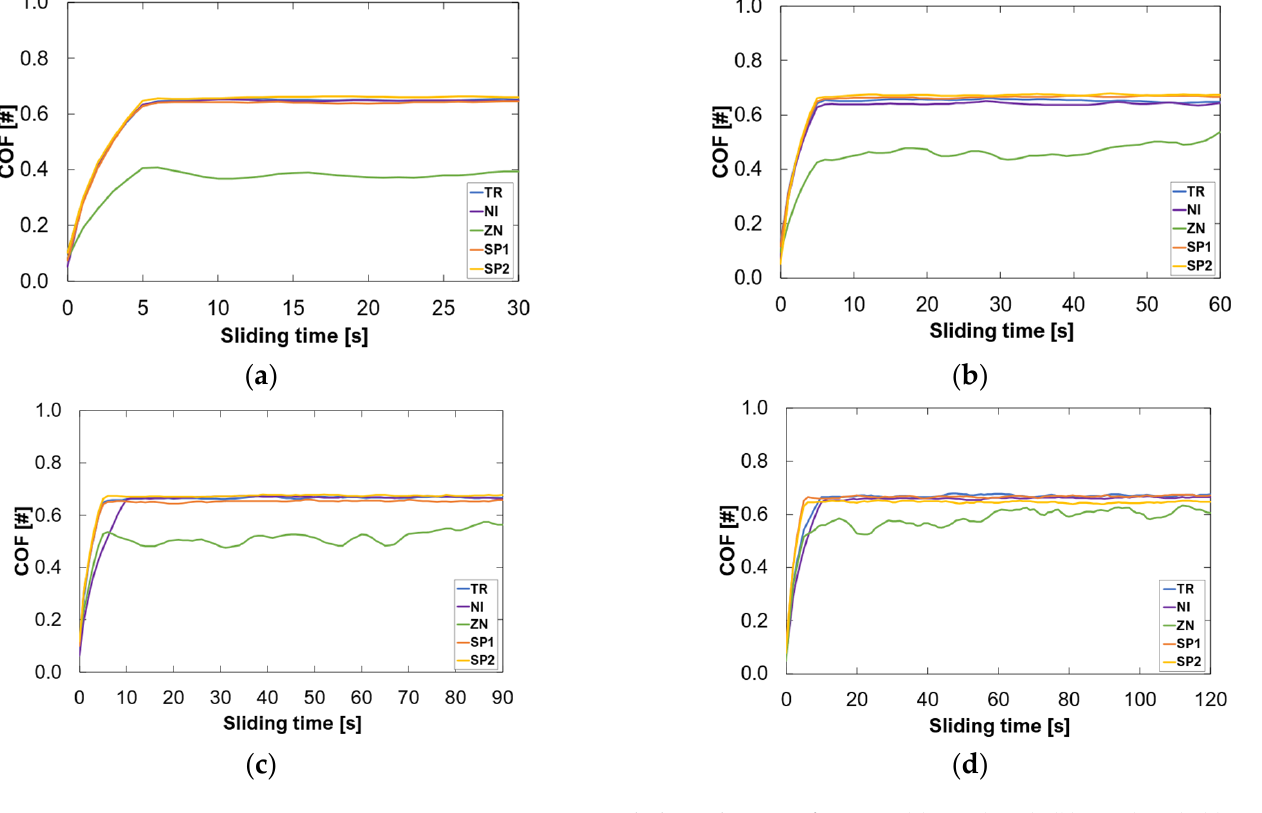
Figure 9. COF vs time curves in tribological IT tests for 2 Hz: ( a ) 30 s (IT30), ( b ) 60 s (IT60), ( c ) 90 s (IT90), and ( d ) 120 s (IT120).